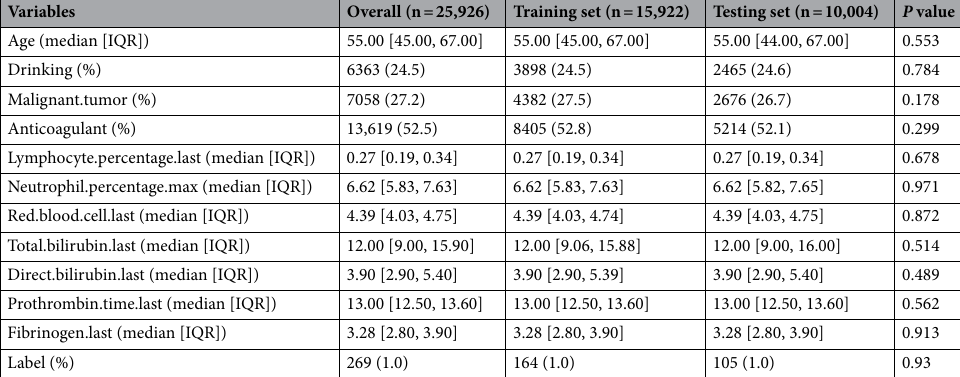
Table 1. Baseline characteristics of subjects. Last: The last test results before the diagnosis of pulmonary embolism. Max: The maximum test results before the diagnosis of pulmonary embolism.